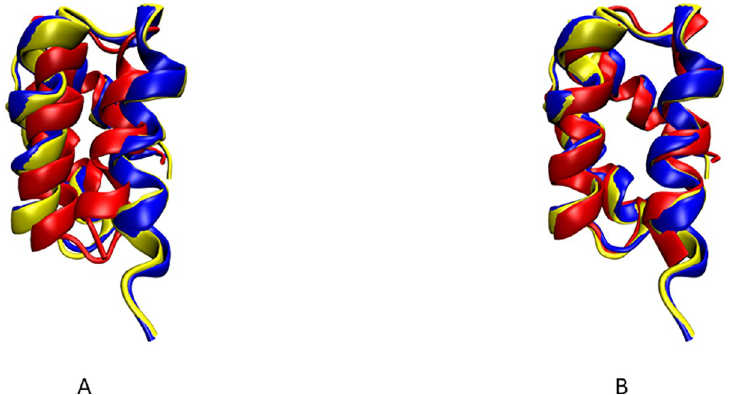
Fig 2. Results for PF2048.1 (in red) A) before energy minimization and B) after energy minimization are shown superimposed to the traditional NOE structure generated without RDCs (in blue) and with RDCs (in